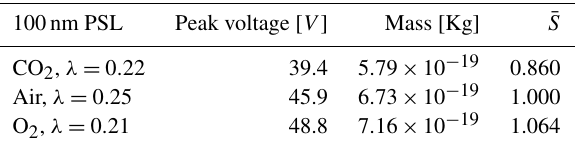
Table 3. Normalized particle mass-to-charge ratio of 100nm PSL spheres for CO 2 , air, and O 2 ( ω is fixed at